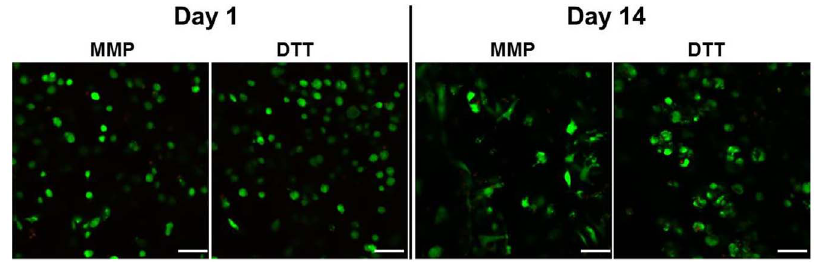
Figure 3. The cell viability staining on day 1 (A) and 14 (B) of the culture. Bar =100 m m.